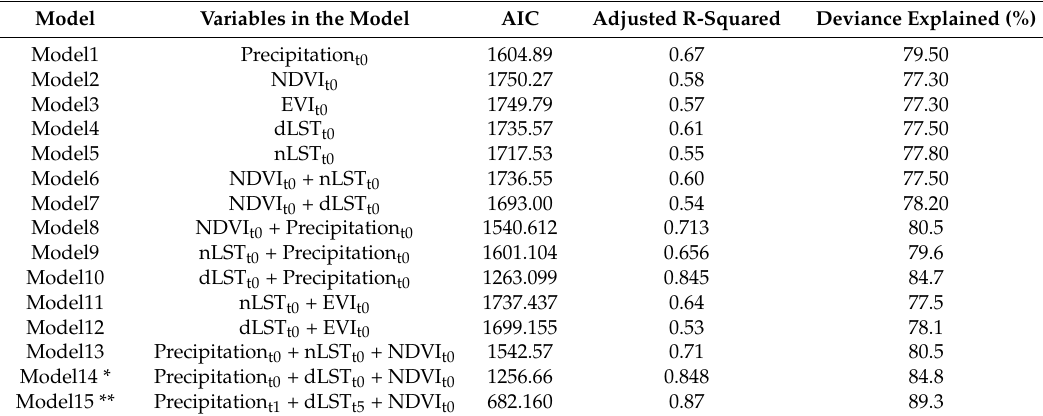
Table 5. Diagnostics of dengue-environmental parameters